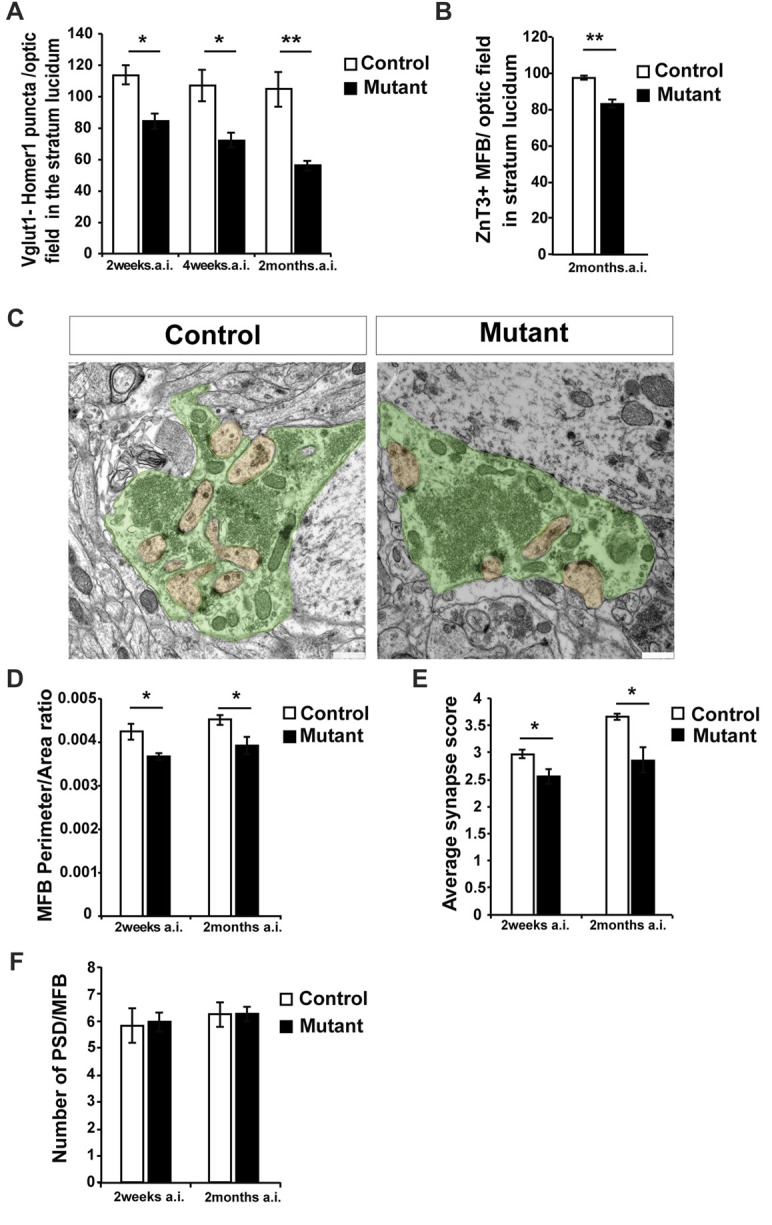
Loss of Bcl11b/Ctip2 expression impairs mossy fiber (MF) terminals. (A) Quantification of overlapping puncta for vesicular glutamate transporter 1 (Vglut1; presynaptic marker of glutamatergic synapses) and Homer1 (postsynaptic marker of glutamatergic synapses) per optic field in the stratum lucidum (n = 3; 10 sections per animal). (B) Count of Zinc Transporter-3 (ZnT3)-labeled MF terminals per optic field in the stratum lucidum (n = 3; 10 sections per animal). (C) Representative pictures of control and mutant MFBs; scale bar, 500 nm. (D) Perimeter/area ratio of control and mutant MFBs (n = 6). (E) Average synapse score for mutants and controls (n = 4). (F) Number of postsynaptic densities per MFB (n = 6). Error bars, SEM; Mann-Whitney U test, *p < 0.05, **p < 0.01; MFB, mossy fiber bouton; PSD, postsynaptic density; a.i., after induction (of Bcl11b/Ctip2 mutation).